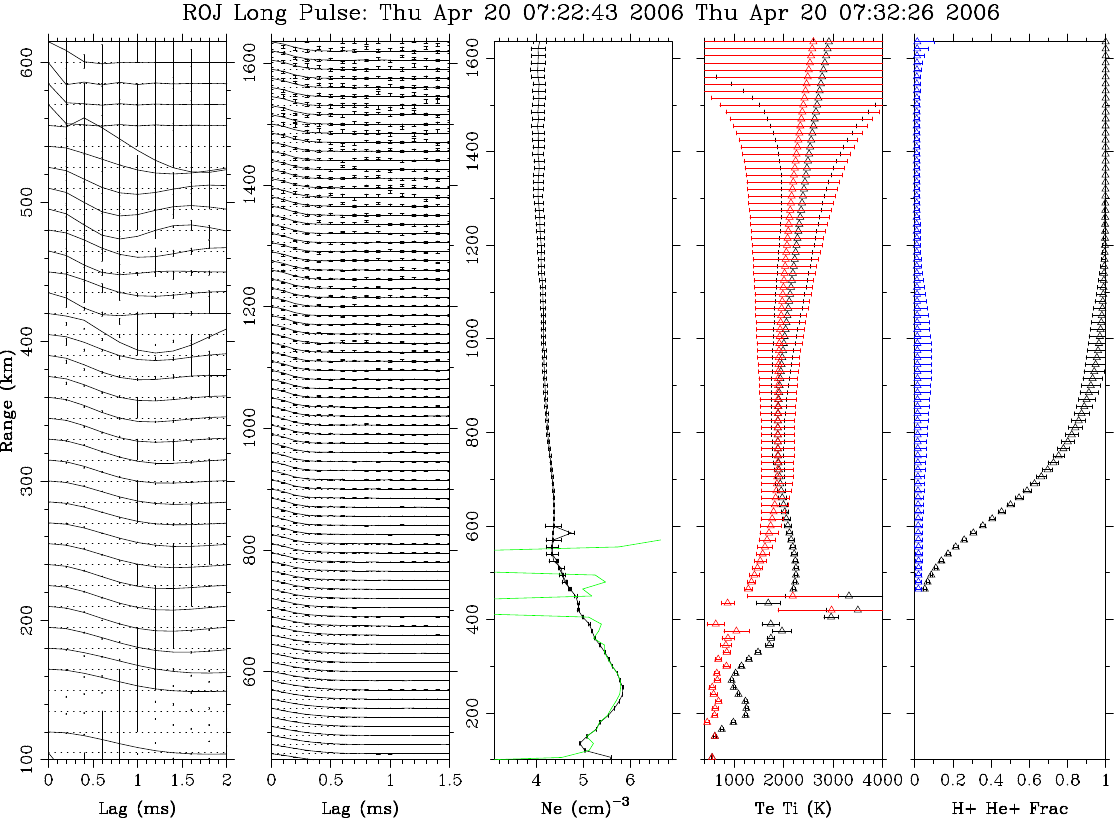
Fig. 5. Jicamarca profiles for 07:30 LT (12:30